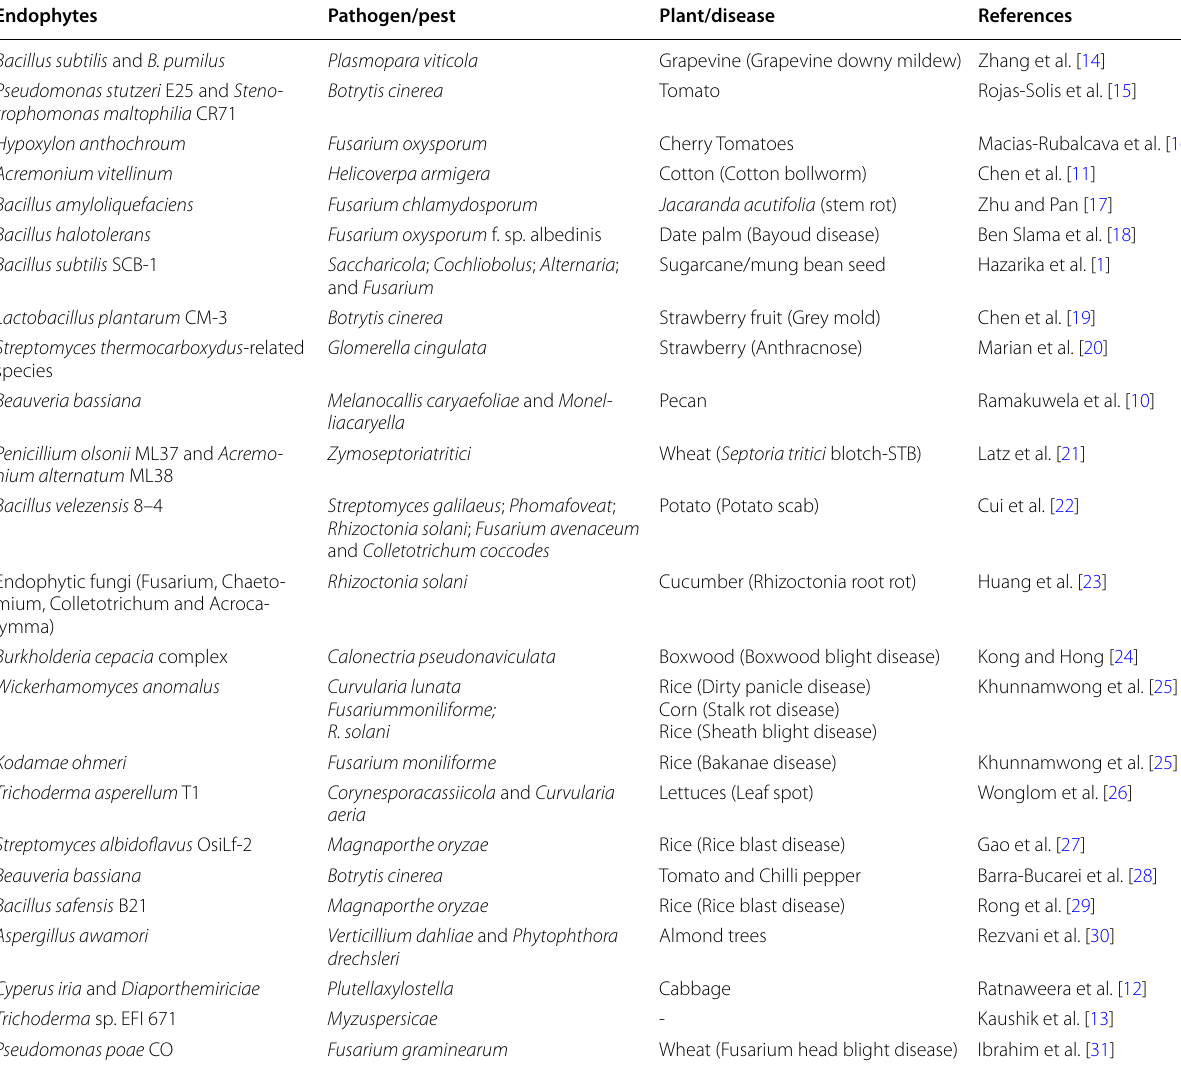
Table 1 Biocontrol potential of endophytes against insect pest and